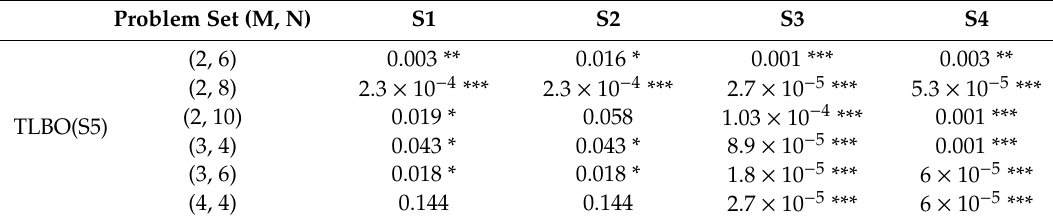
Table 7. Wilcoxon rank sum